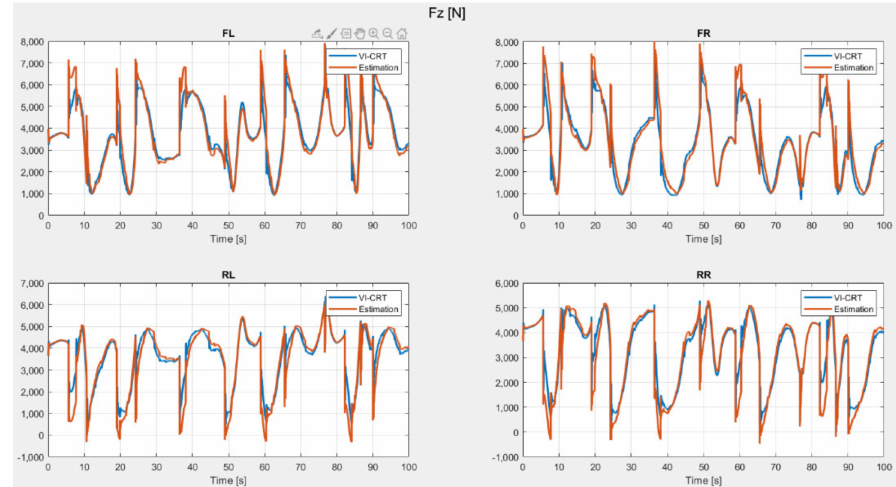
Figure 3. Total vertical force (Fz) acting on each tire.